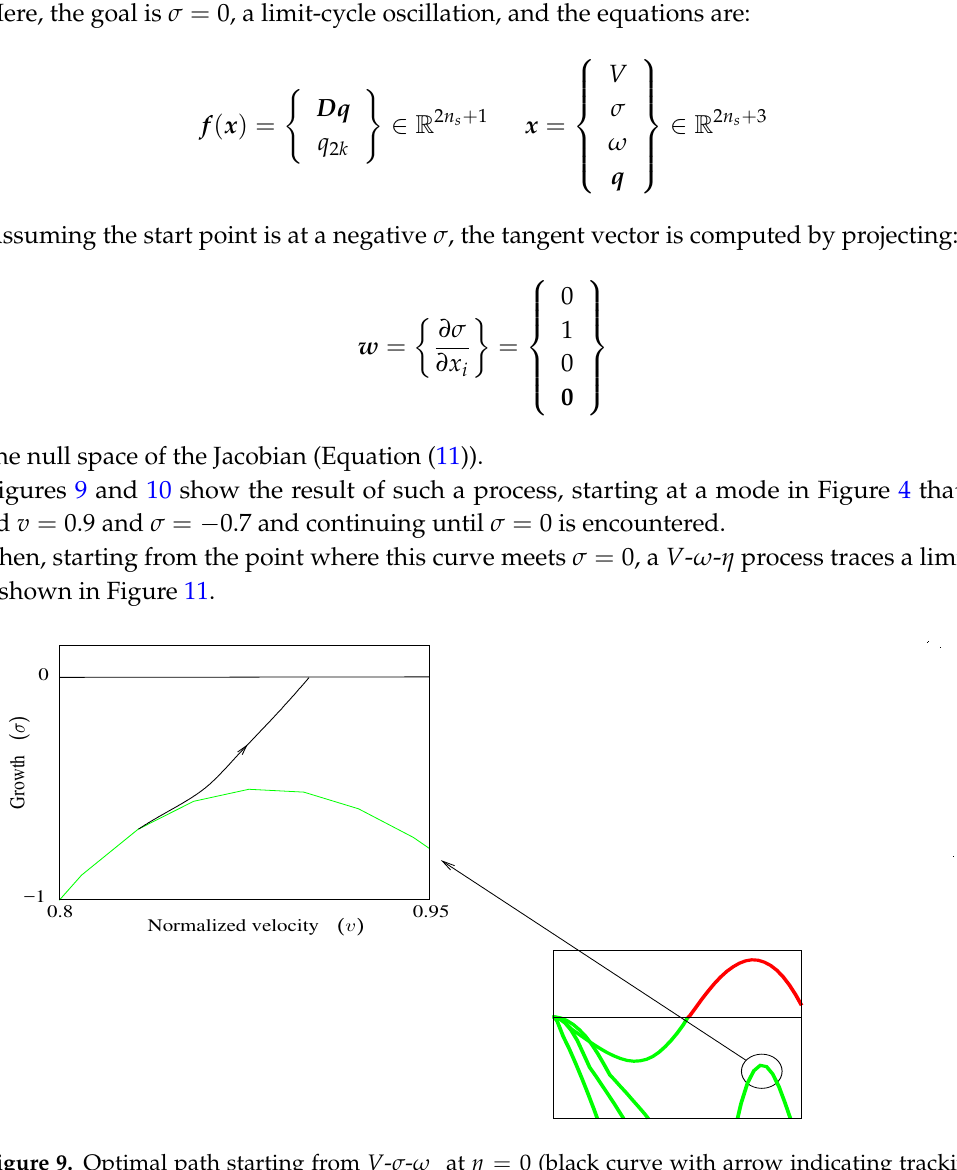
Figure 9. Optimal path starting from V - σ - ω at η = 0 (black curve with arrow indicating tracking direction) (Green means stable, red means unstable).